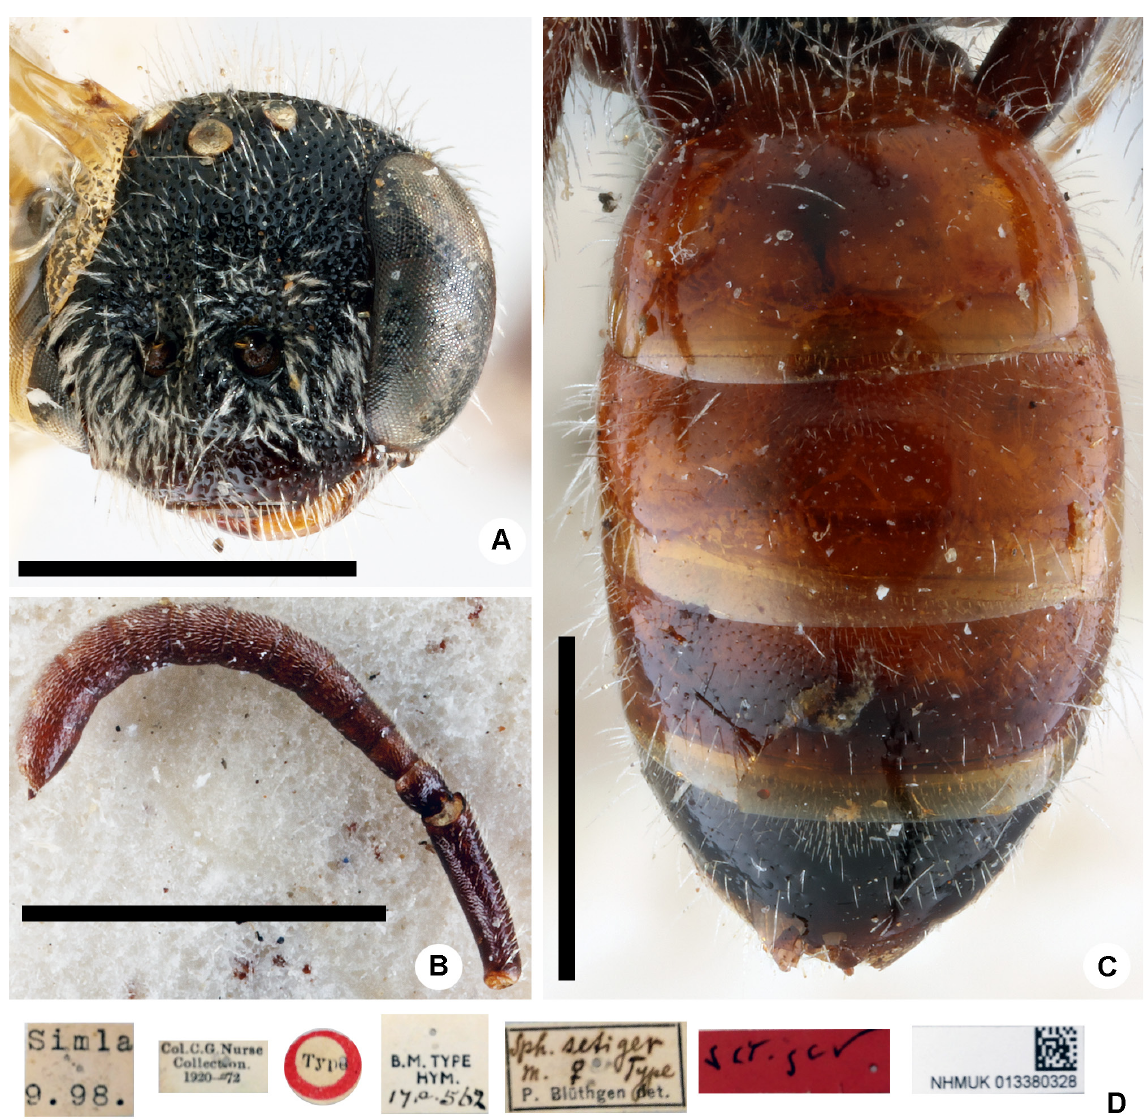
Fig. 16. Sphecodes setiger Blüthgen, 1924. Holotype, ♀ (NHMUK 013380328). A . Head in frontal view. B . Antenna in lateral view. C . Metasoma in dorsal view. D . Labels. Scale bars = 1